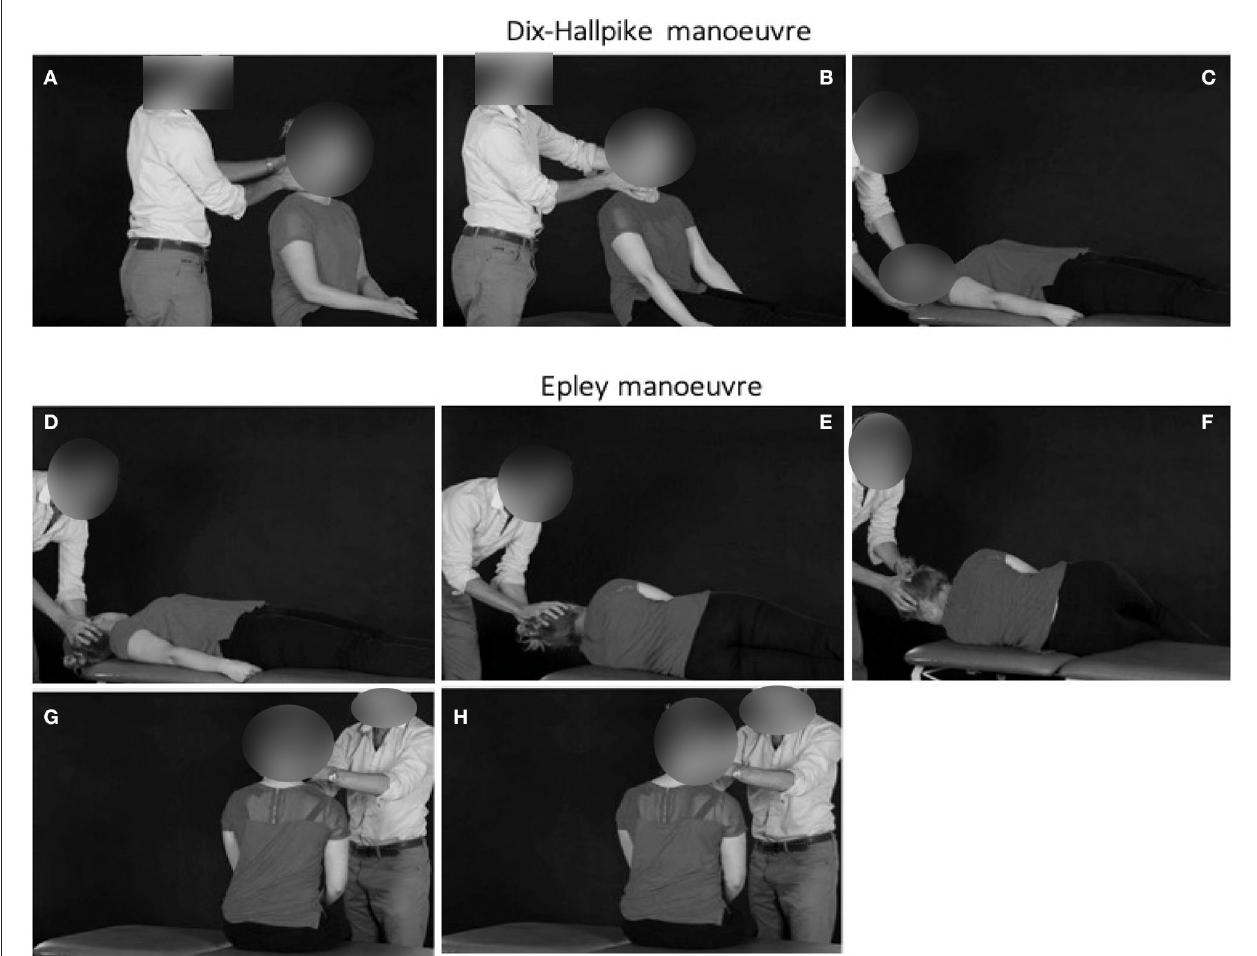
FIGURE 1 | The first manoeuvre is the Dix–Hallpike manoeuvre exploring the right ear (A–C) . The patient begins seated in the couch, with the feet longitudinally. The head is then turned towards the ear being explored (right ear in this case). The patient is then lowered backwards such that the head is hyperextended by approximately 30 ◦ , and overhangs the end of the couch. In the presence of BPPV, there is upbeat and torsional nystagmus beating toward the ground with vertigo, usually lasting only 5–10s. It may be necessary to open the eyes lightly using your thumb and index fingers to see the nystagmus more clearly. Epley manoeuvre for treating right ear posterior canal BPPV (D–H) . After 30s, the patient’s head is rotated toward the other side [leftwards here, (D) ], and held in this position for a further 30s. During this time, the patient is asked to rotate the body so that he/she is lying on their left shoulder (E) . It is important to hold onto the head while the patient is instructed to turn, so that it does not change position. The patient’s head is rotated by a further 90 ◦ to the left, to face the ground (F) , and held for 30s. The patient is now sat up, with the head still looking over the right shoulder (G) , for 30s. Finally, the patient’s head is brought toward the midline, and the neck flexed, chin down through 45 ◦ for a final 30s (H) . The procedure is reversed for left posterior canal-BPPV. Adapted from